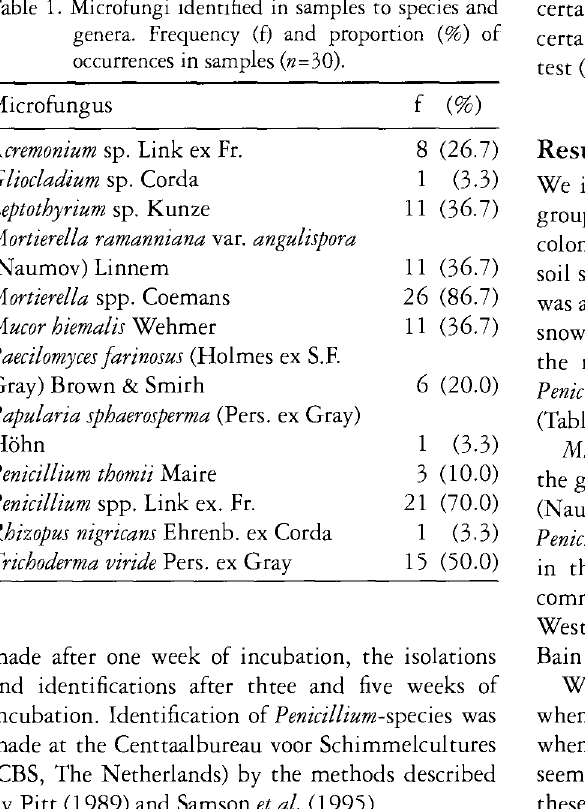
Table 1. Microfungi identified in samples to species and genera. Frequency (f) and proportion (%) of